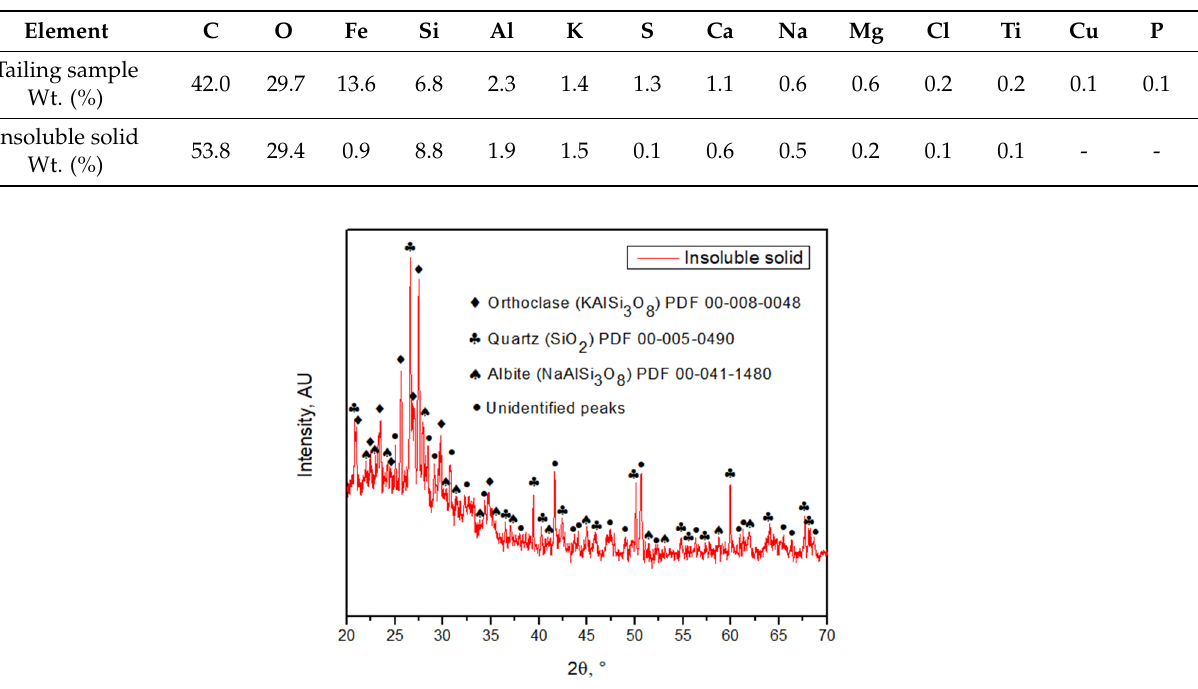
Figure 6. ( a ) SEM image and ( b ) EDX mapping of an insoluble solid sample at 100× magnification. Table 2. Elemental composition of the tailing sample and the insoluble solid obtained by EDX.